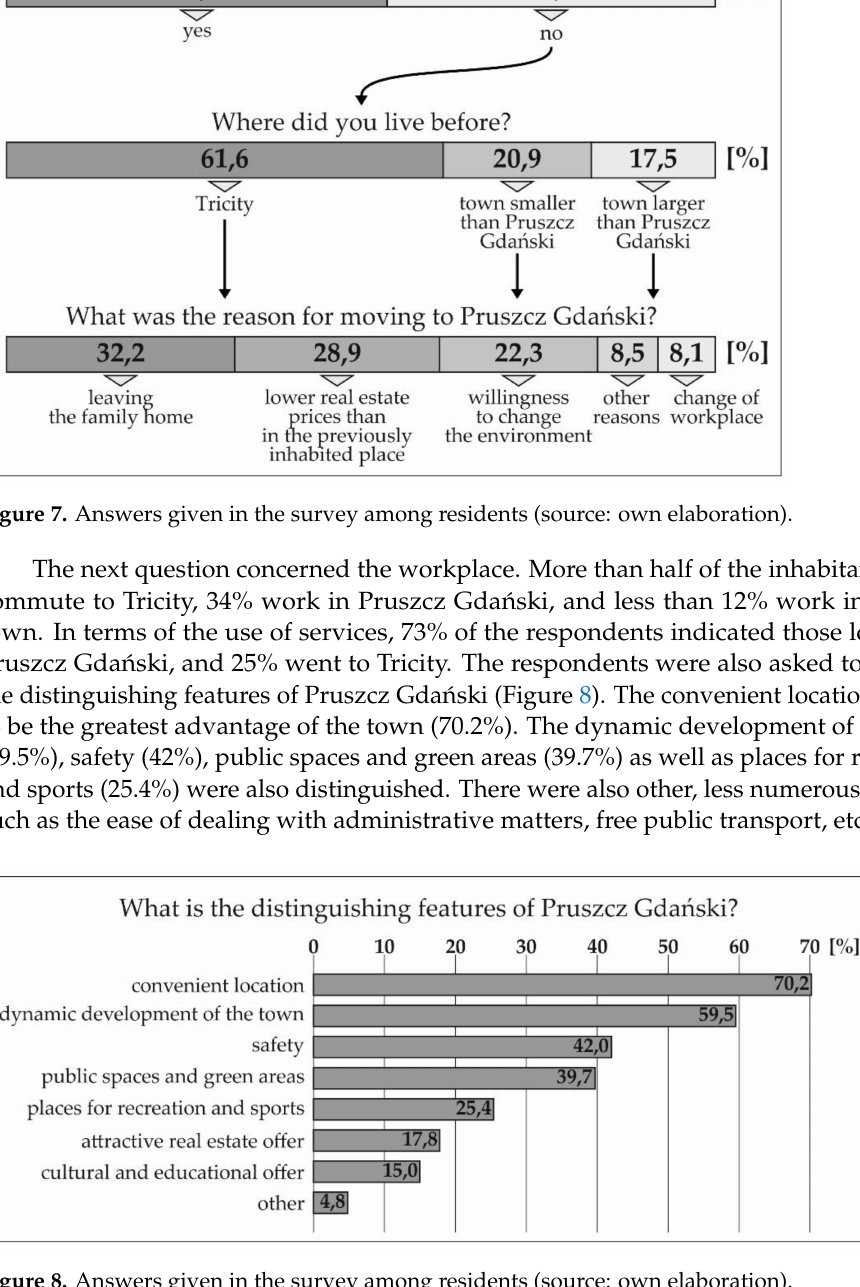
Figure 8. Answers given in the survey among residents (source: own